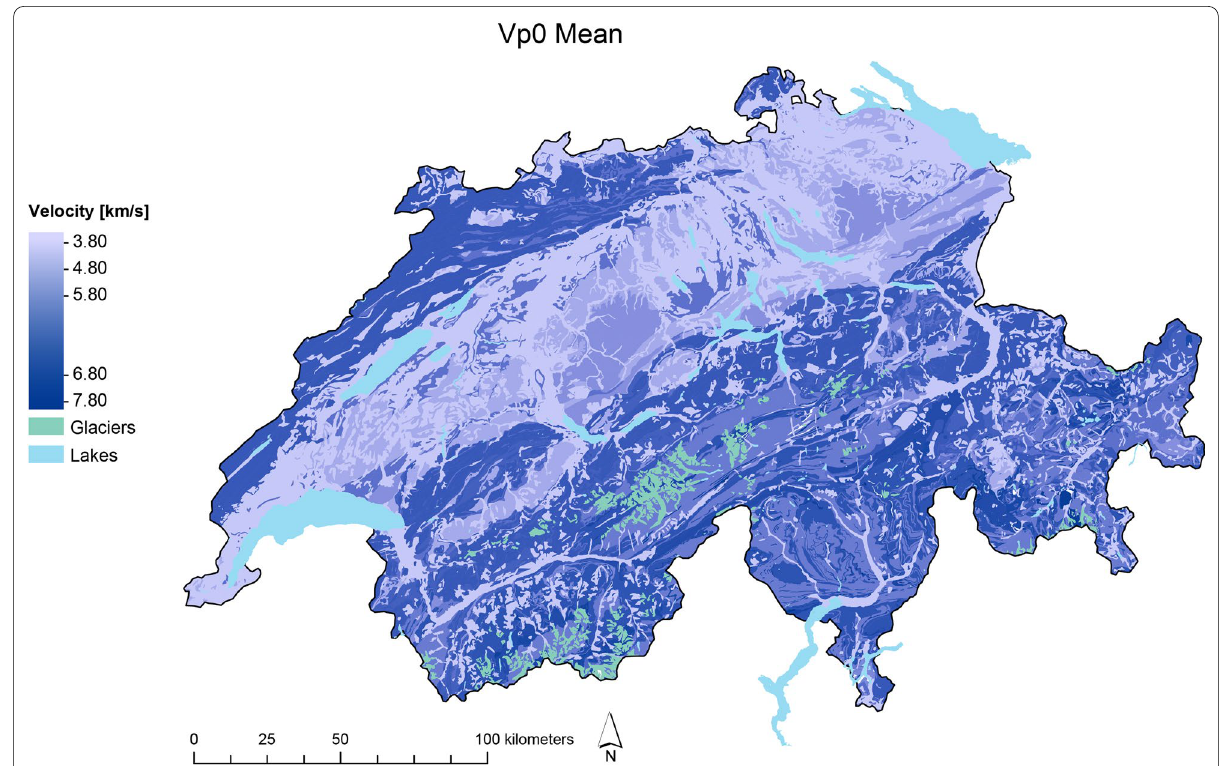
Fig. 12 Mean Velocity of compressional waves (Vp) calculated at 0 Pressure (see text and Fig. 5 for